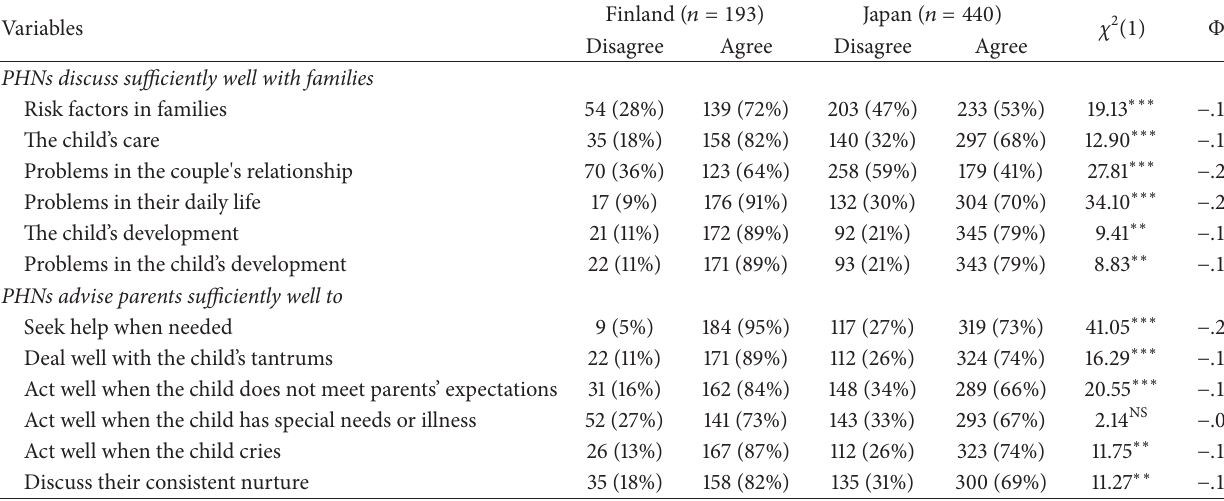
Table 3: Intervention to support children and their families.